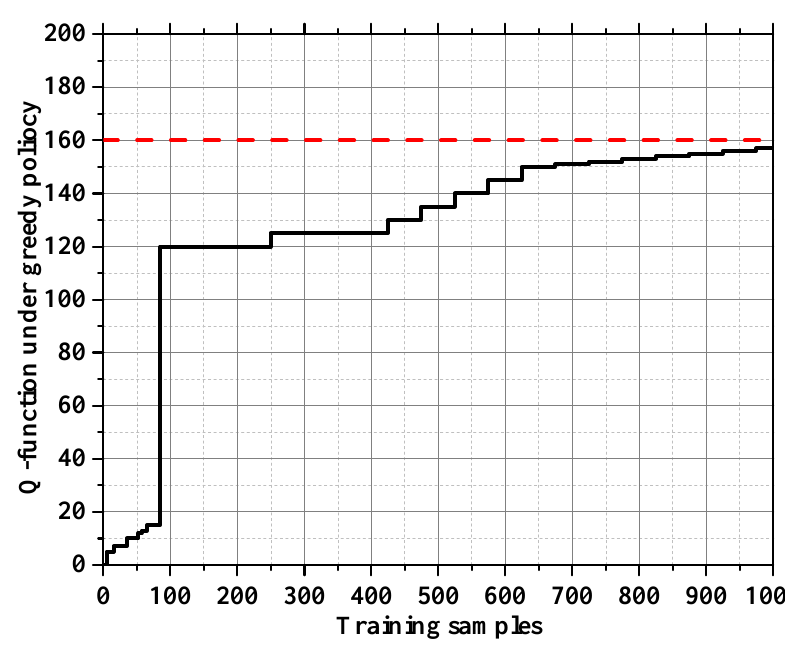
Figure 6. The convergence of the QL at state ( c , m ) = (0, 50). The red dotted line signifies the ideal value, while the black dotted line denotes the point at which convergence occurs.